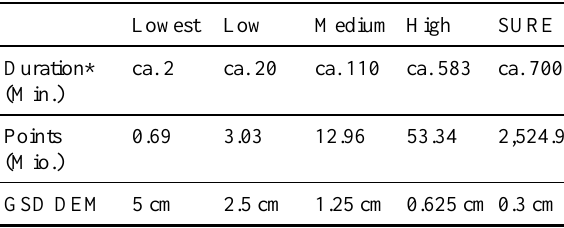
Table 1: Comparison of derived 3D point clouds depending on the software settings of Agisoft Photoscan Professional (v